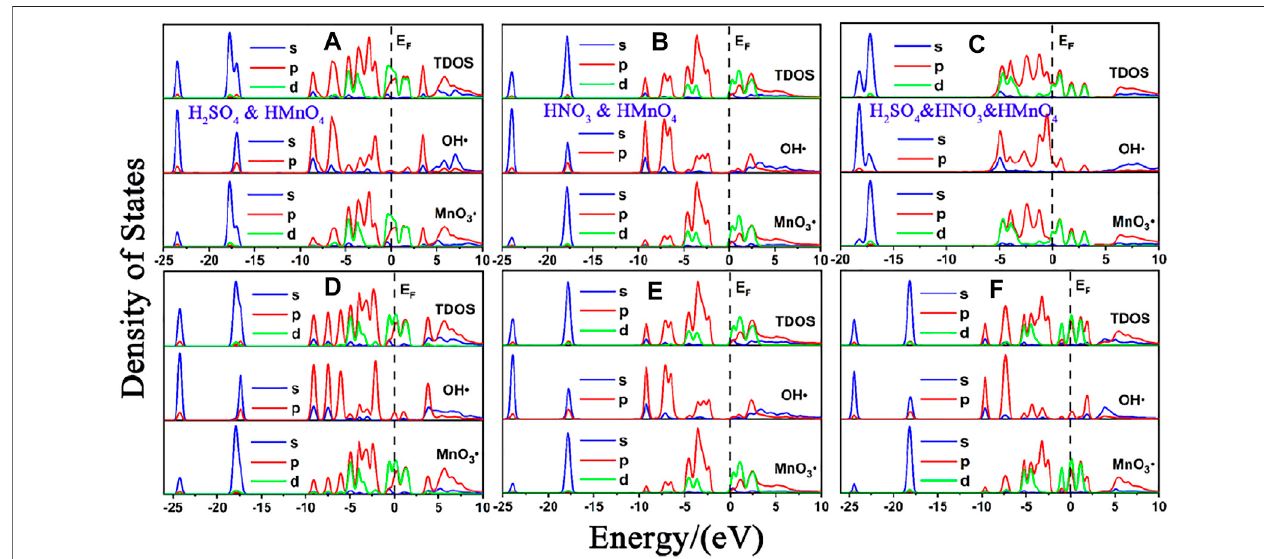
FIGURE 7 | DOS of mix-component acid molecules in the absence of water. (A) , (B) and (C) are the DOS of HMnO 4 in the case of H 2 SO 4 and HMnO 4 , HNO 3 and HMnO 4 and H 2 SO 4 and HNO 3 and HMnO 4 on non-defect graphene, respectively. (D) , (E) and (F) are the DOS of HMnO 4 in the case of H 2 SO 4 and HMnO 4 , HNO 3 and HMnO 4 and H 2 SO 4 and HNO 3 and HMnO 4 on Stone-Wales defect graphene, respectively. In each diagram, the top represents the TDOS, the middle represents the (cid:129) (cid:129) LDOS pf MnO 3 and the bottom represents the LDOS of OH .